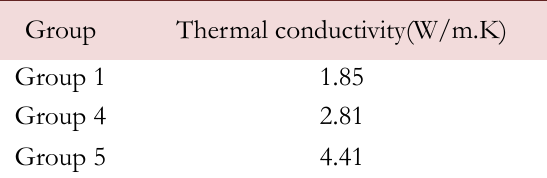
Table 8: Test results of thermal